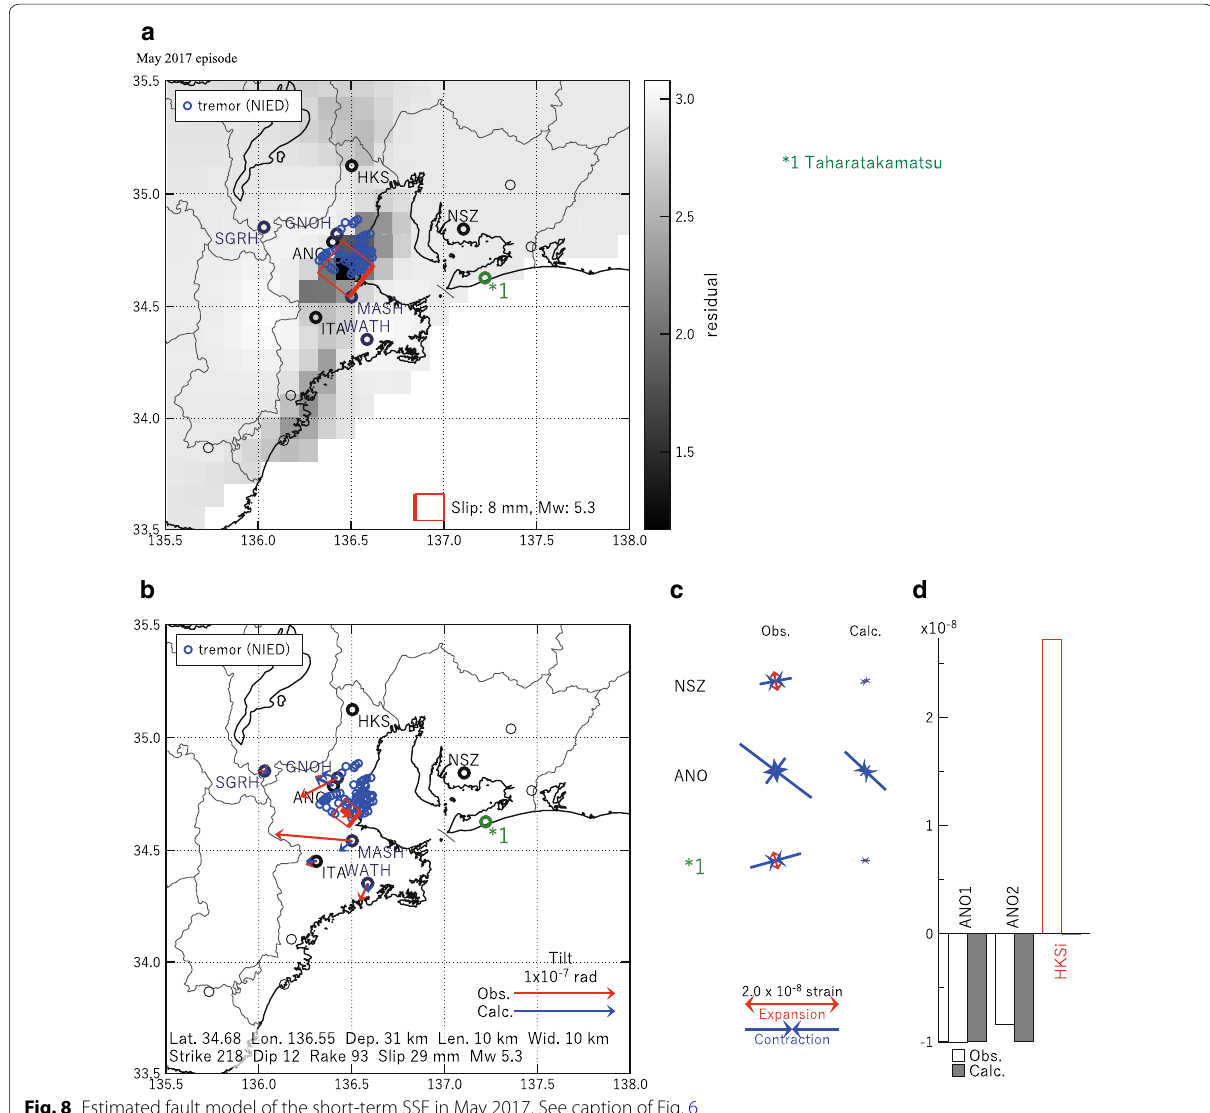
Fig. 8 Estimated fault model of the short-term SSE in May 2017. See caption of Fig.